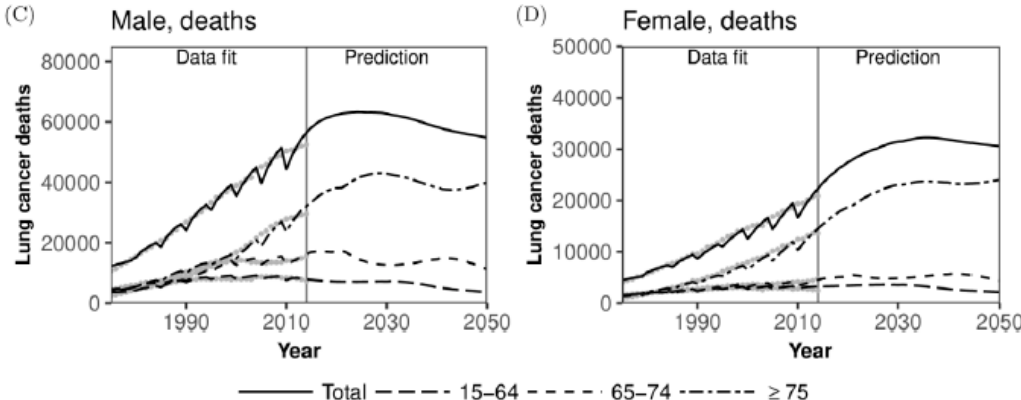
Figure 4. Comparisons between observed and predicted absolute numbers of lung cancer cases and deaths in Japan. Comparisons between observed and predicted absolute numbers of lung cancer cases and deaths are shown by age group and sex. ( A ) Lung cancer incidence in men, ( B ) Lung cancer incidence in women, ( C ) Mortality in men, and ( D ) Mortality in women. Bold dashed line represents working-age population aged 15–64 years, thin dashed line corresponds to those aged 65–74 years, uneven dashed line represents those aged 75 years or older, and solid line represents the entire population. Grey dots before 2014 were used to estimate model fitting parameters via the maximum likelihood method, and lines for 2015 and later indicate predictions calculated using maximum likelihood estimates at the latest time. The 95% confidence intervals are omitted from predictions because of the narrow uncertainty bounds.